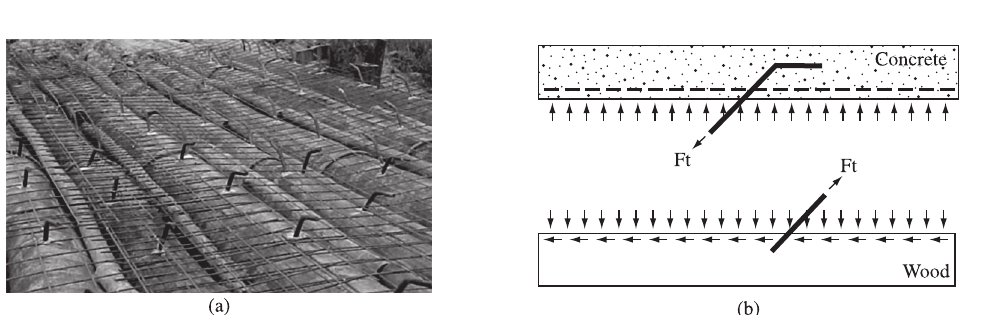
Figure 1. Wood/concrete connection system: a) Detail of a composite bridge deck before concreting; b) Glued steel rod connector at the interface of the materials.